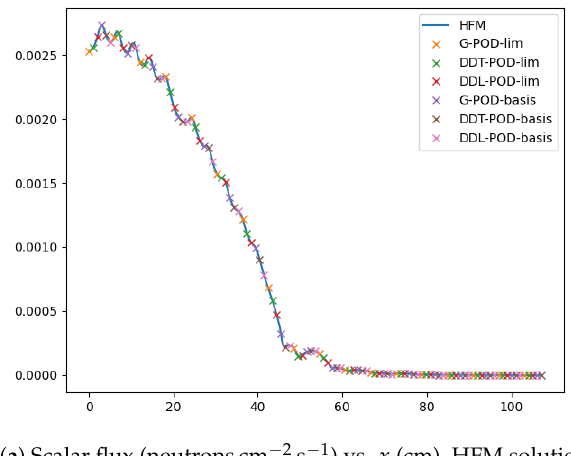
for all POD-based ROMs, with the limited number of snap- shots or smart the selection of number of basis functions, in crosses.